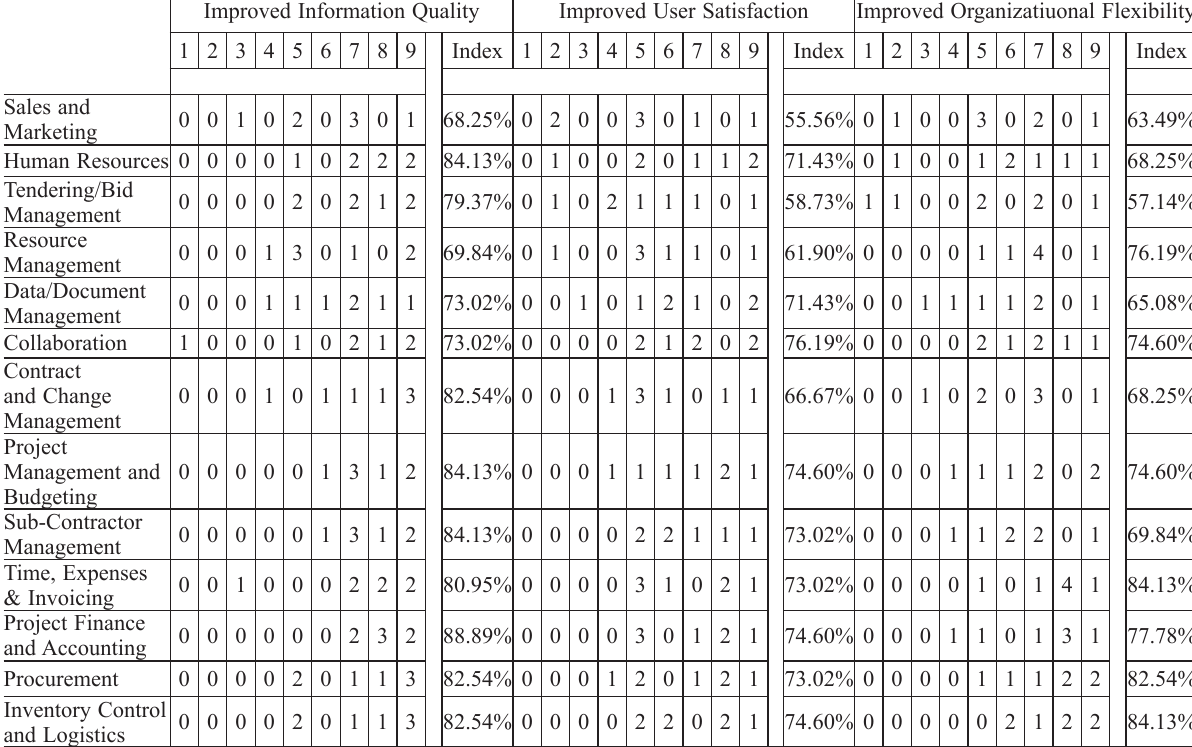
Table 4. Modules’ index for benefits: improved information quality, users’ satisfaction, and organizational